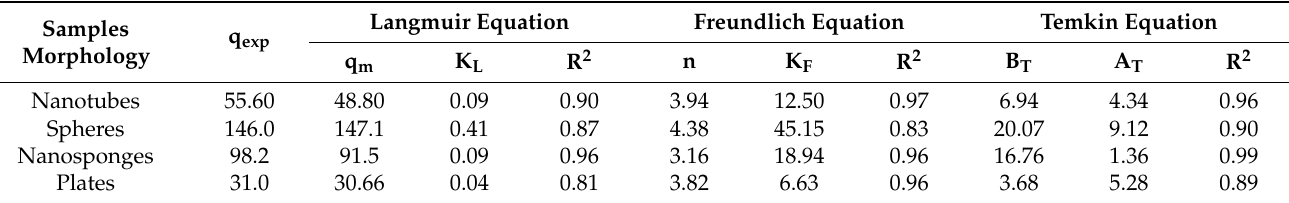
Table 3. Equation constants of MB sorption isotherms.